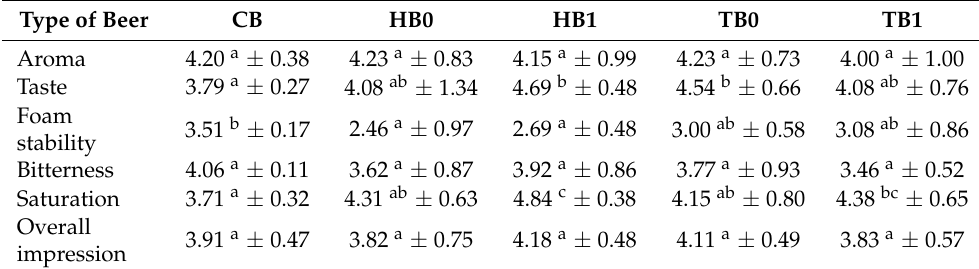
Table 4. Sensory analysis of fruit wheat beer.